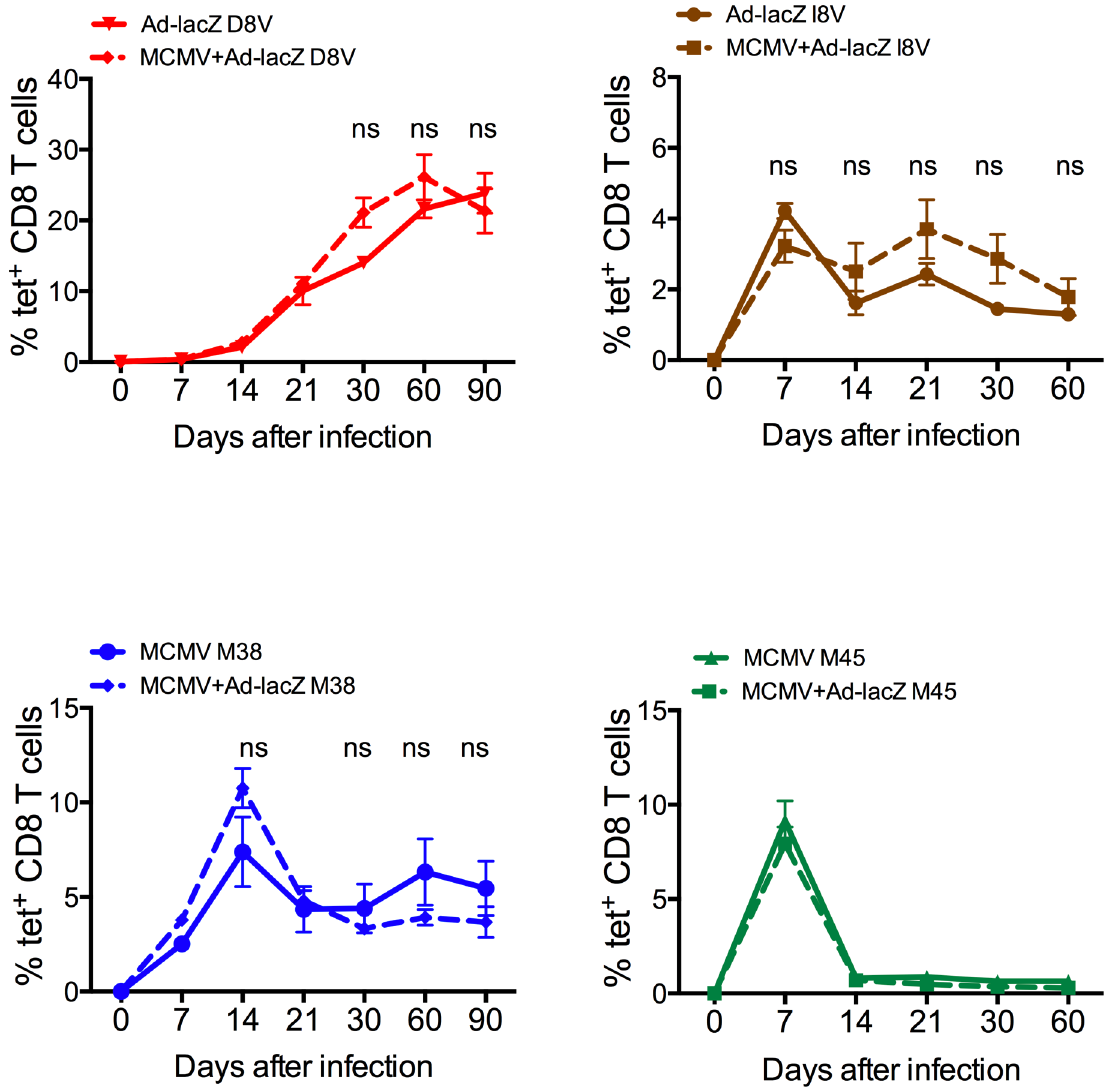
Fig 1. Simultaneous infection with MCMV and Ad-lacZ. Groups of C57BL/6 mice were co-infected with a mixture of 2x10 9 pfu Ad- LacZ and 5x10 6 pfu MCMV by the i.v. route (N = 4). Groups of mice were infected with only MCMV or Ad-lacZ as control (N = 3). At the indicated time-points post-infection blood was sampled and the levels of Ad-lacZ-specific inflating memory (D8V, upper left) and central memory (I8V, upper right) and MCMV-specific inflating memory (M38, lower left) and central memory (M45, lower right) were measured by ex vivo tetramer